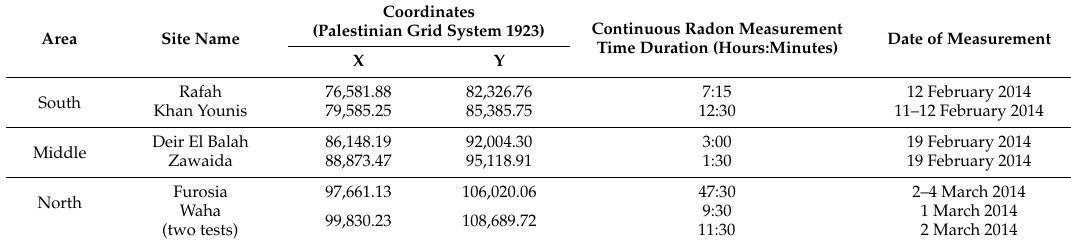
Table 1. General information about the continuous radon measurement locations.